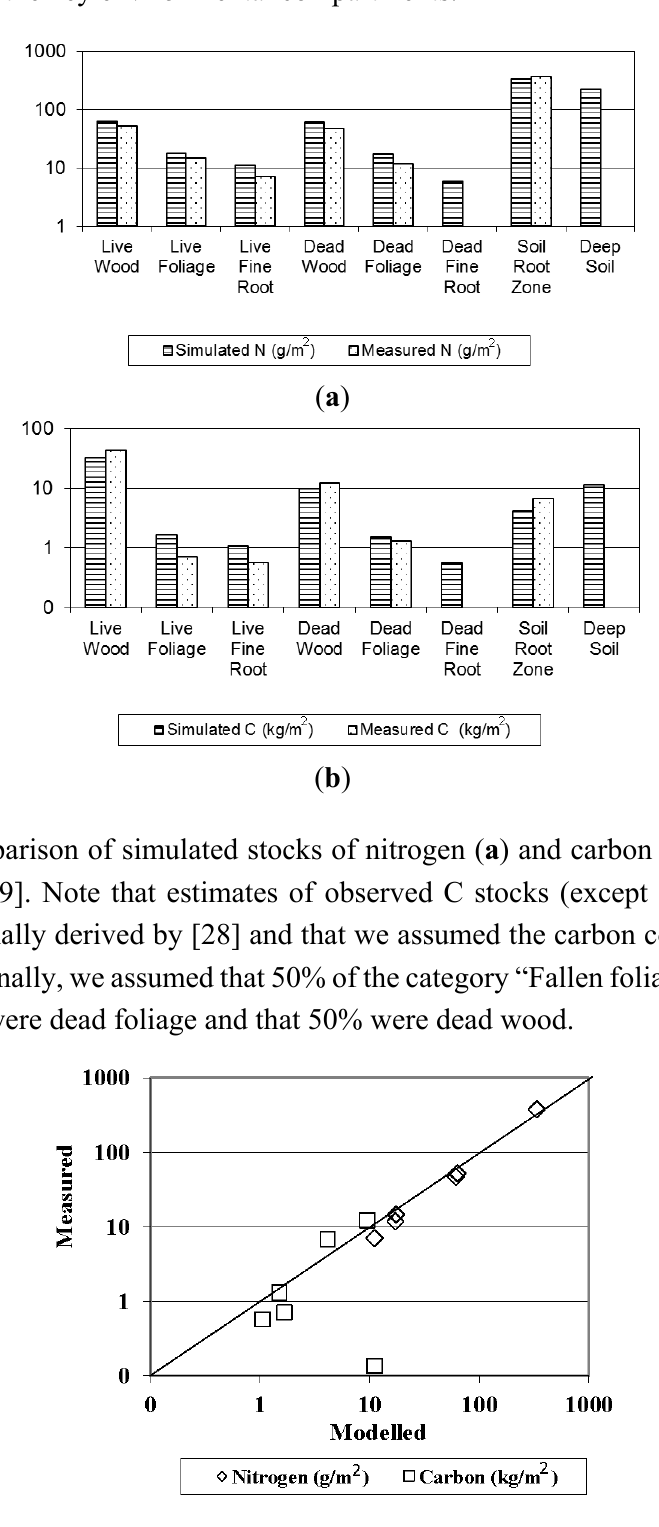
Figure 3. Measured versus modeled annual yearly storage of nitrogen and